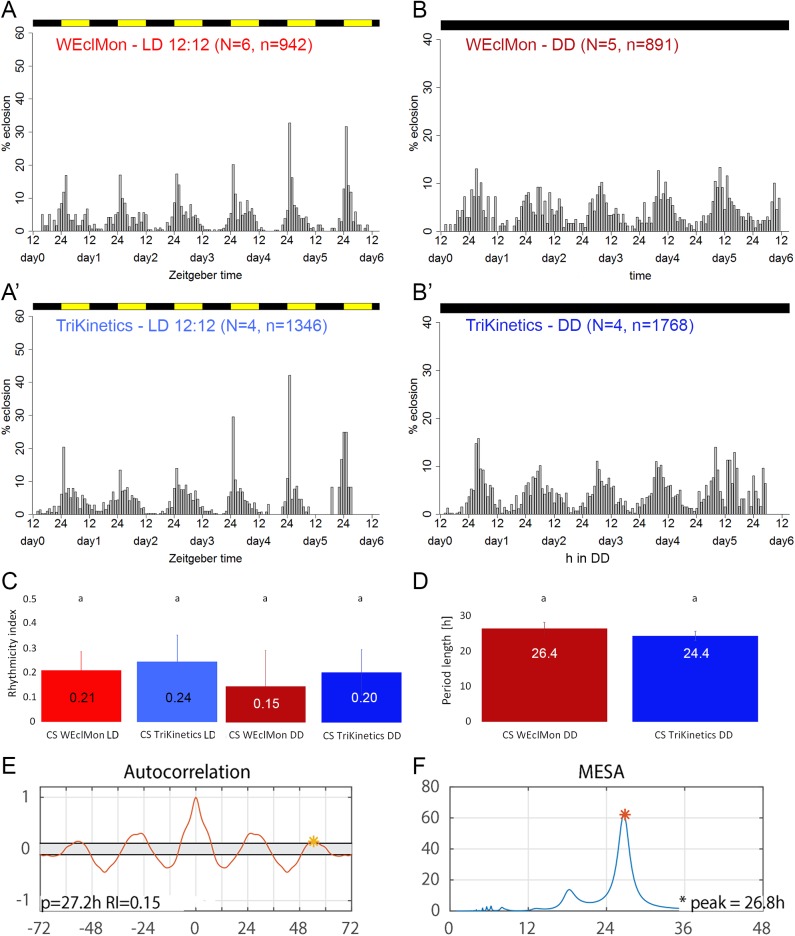
Comparison between eclosion rhythms in the WEclMon and TriKinetics monitor systems under laboratory conditions.Eclosion rhythms monitored by the WEclMon system equipped with infrared light source (A, B) and the TriKinetics system (A’, B’) under LD12:12 (A, A’), and DD (B, B’), after entrainment at LD12:12 at 20°C. Each bar represents the normalized percentage (number of flies eclosed in hour x/total number of flies eclosed during the day) of eclosion; colours represent the light regime. In both systems, lights-on eclosion peaks are visible under LD conditions (A, A’). C) Rhythmicity indices (RIs, ± s.d.) for the experiments shown in A-B’. In both systems and conditions, autocorrelation analysis indicated weak rhythmicity. The RI differences between monitors and conditions are not significant. D) Free-running periods (± s.d.) for the DD experiments shown in B and B’ are not significantly different between monitor types. E) Autocorrelation and F) MESA analysis results for eclosion rhythms monitored by the WEclMon system equipped with a red light source under DD. The RI of 0.15 and the period of 26.8h are similar to the values obtained with an infrared light source (see C-D), N = 5; n = 2056.